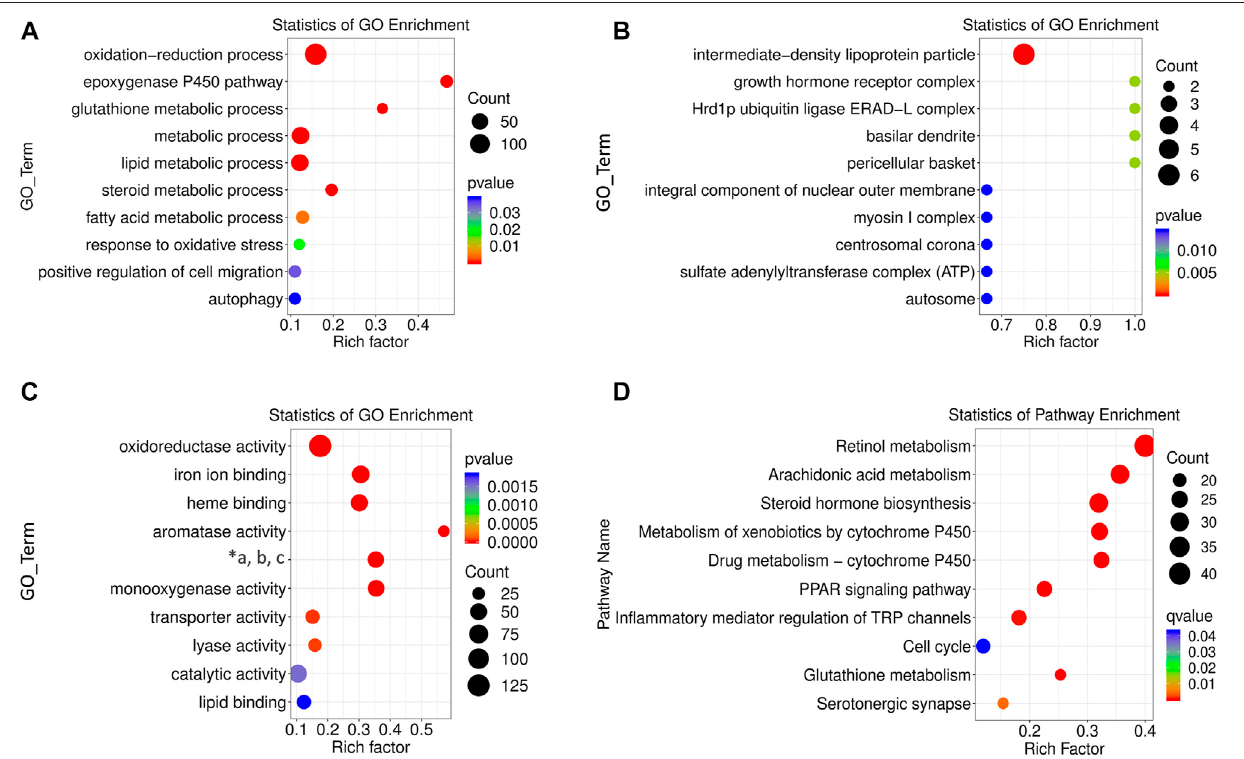
FIGURE 4 | GO and KEGG enrichment analysis of differentially expressed lncRNAs. BP (A) , CC (B) , and MF (C) terms for enrichment (rich factor) of differentially expressed lncRNAs in GO analysis ( “ *a, b, c ” refers to “ oxidoreductase activity, acting on paired donors, and molecular oxygen, respectively. ” ) (D) KEGG pathways enriched by differentially expressed lncRNAs. The size of the circle represents S gene numbers. The color depth represents the statistical signi fi